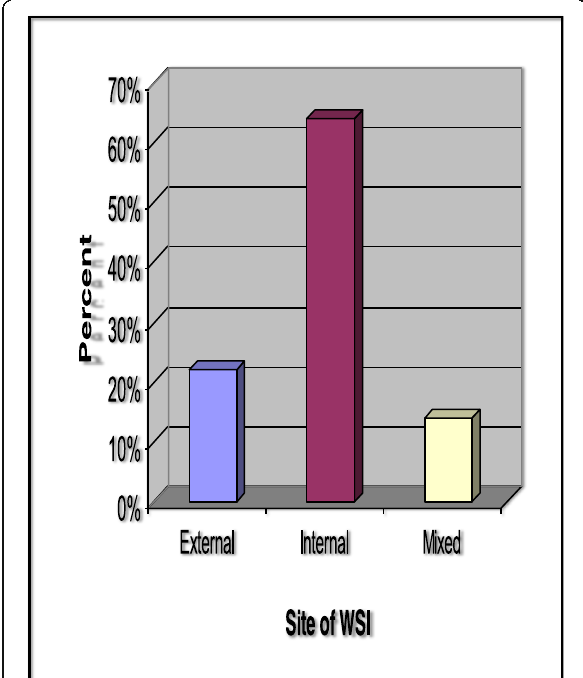
Fig. 1 Site of watershed infarction among cases. Among those 50 patients with acute WSI, 11 watershed infarction (WSI) (22%) were located externally (cortical), while 32 WSI (64%) were located internally (sub cortical) and seven WSI (14%) were mixed, i.e., both external and internal. WSI watershed infarction